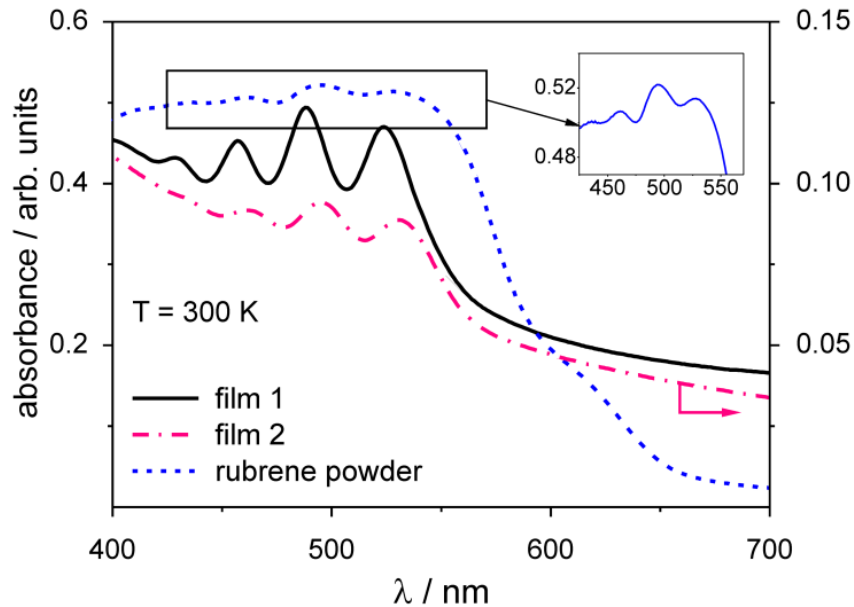
Figure 2. Absorbance spectra of rubrene films on monocrystalline Si (film 1, black line) and on SiO 2 (film 2, dash-dot pink line) deposited from 0.47% and 0.7% wt solutions in 1,1-DCA, respectively; the spectrum of RB powder (dashed blue line) is given for reference, marked area is enlarged (inset); adapted from own work in Proceedings of SPIE; published by Society of Photo-Optical Instrumentation Engineers (SPIE), 2017 [42].